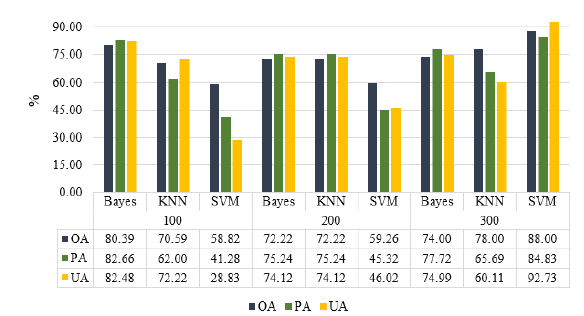
Fig. 6. Comparison of accuracy test based on field samples